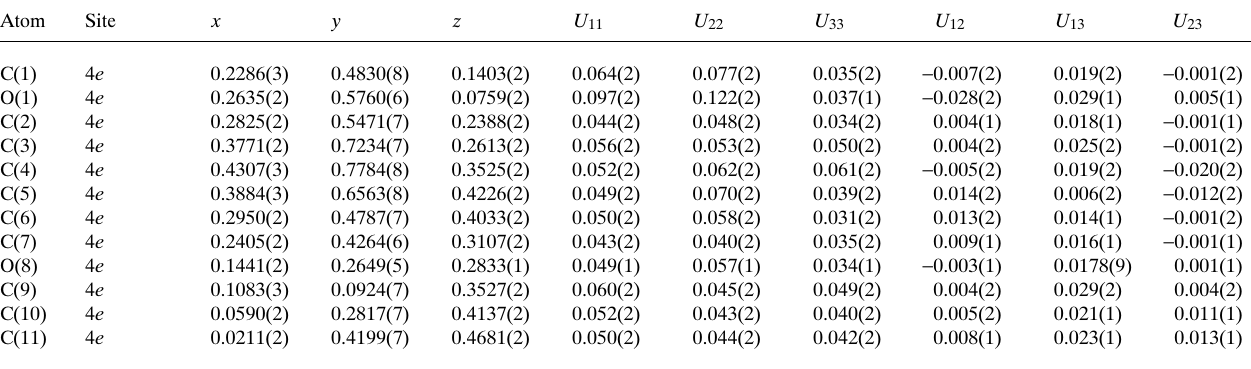
5. Gleiter, R.; Werz, D. B.: Carbon-rich cycles with two and more 1,3- butadiyne units  syntheses, structures and reactivities. In: